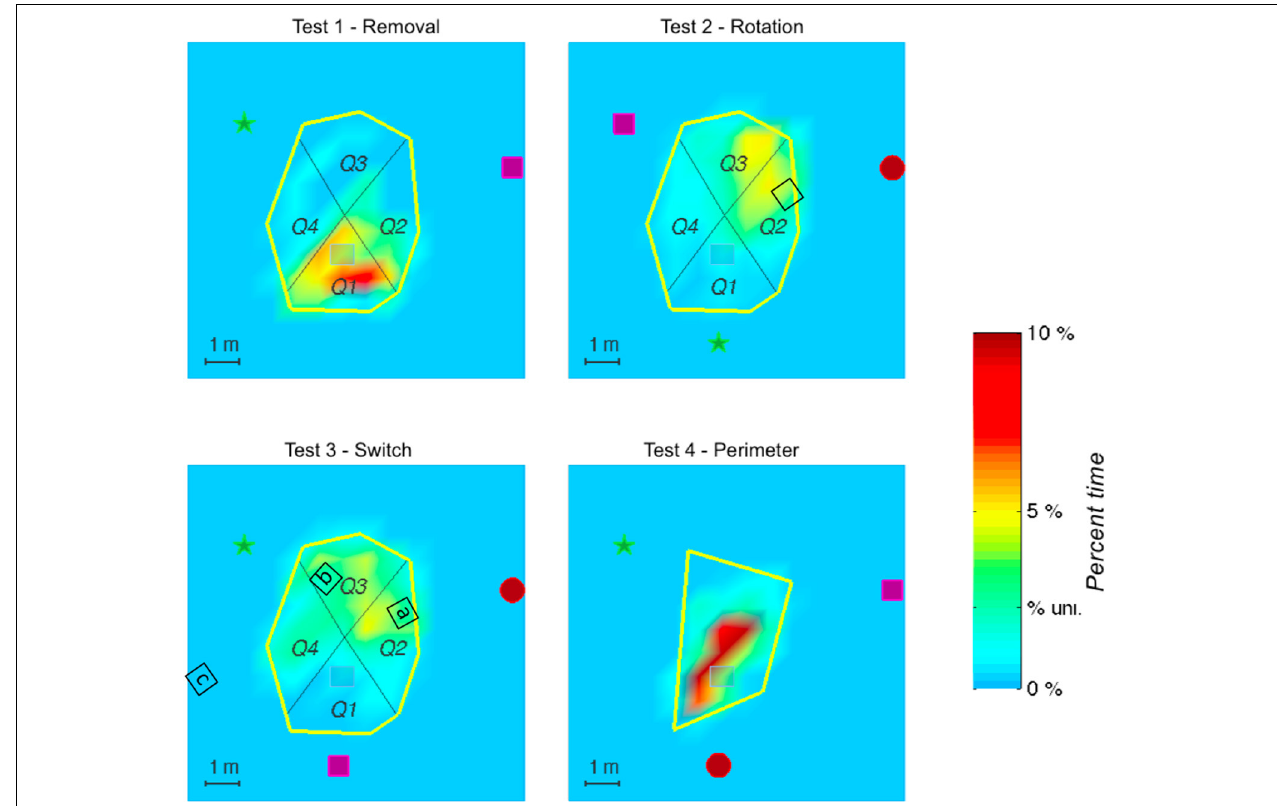
FIGURE 4 | The figure shows the spatial distribution of the time elapsed in the exploration area until the target was found and averaged on all subjects. Color shadings represent percentage of time spent in a given location. The tick label “% uni.” on the scale corresponds to the hypothesis of a uniform spatial distribution. The actual position of the target is represented in gray. The red spot represents the cicada landmark, the green star represents the voice landmark, and the purple square represents the piano landmark. In Test 2—Rotation (landmarks rotation) and Test 3—Switch (inversion of 2 landmarks), the black squares represent different hypothetical positions of the target, corresponding to what could be tested by the participants according to their search strategy relative to the initial landmark